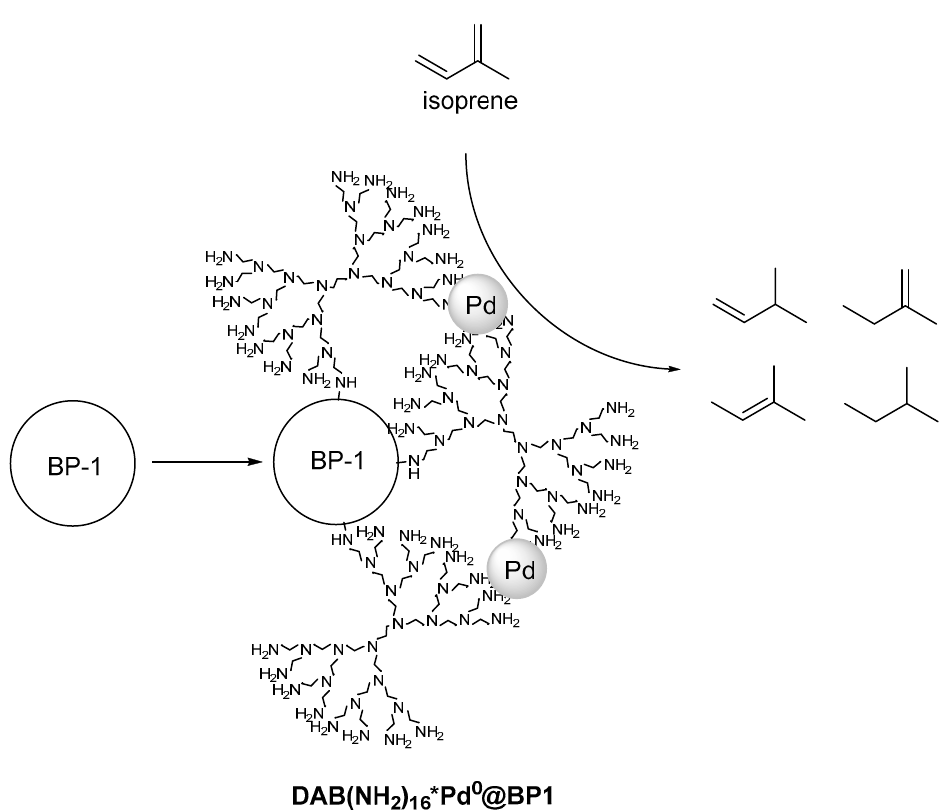
8 of 19 Figure 5. Schematic representation of second-generation silica supported phosphine–palladium terminated PAMAM dendrimers. Highly efficient heterogeneous catalysts for the hydrogenation of conjugate double bonds have been prepared by combining silica–polyamine composite (SPC BP-1) with poly-propyleneimine (PPI) dendrimers containing Pd nanoparticles (Scheme 5).